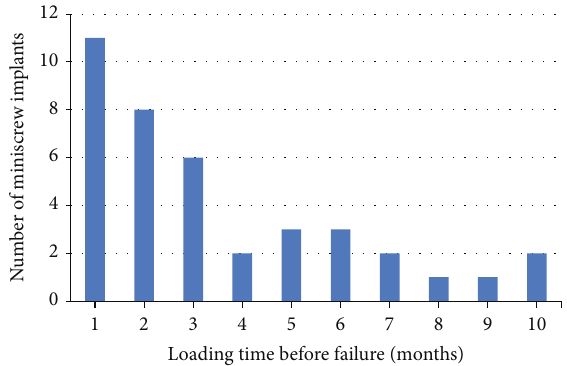
Figure 2: Loading time of failed miniscrew